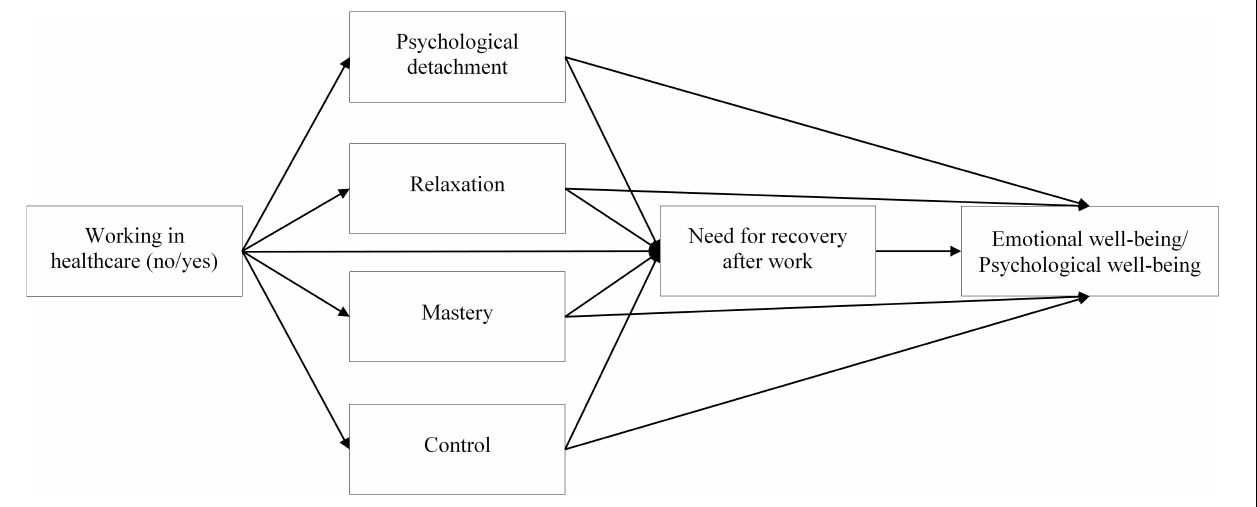
FIGURE 1 | Working